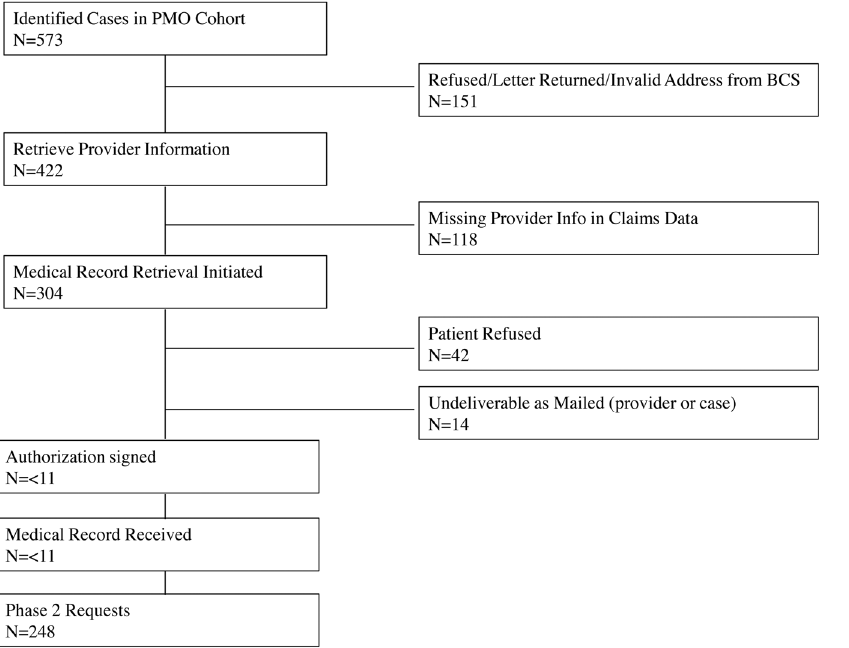
Fig 1. US Medicare Participant Selection Flowchart —